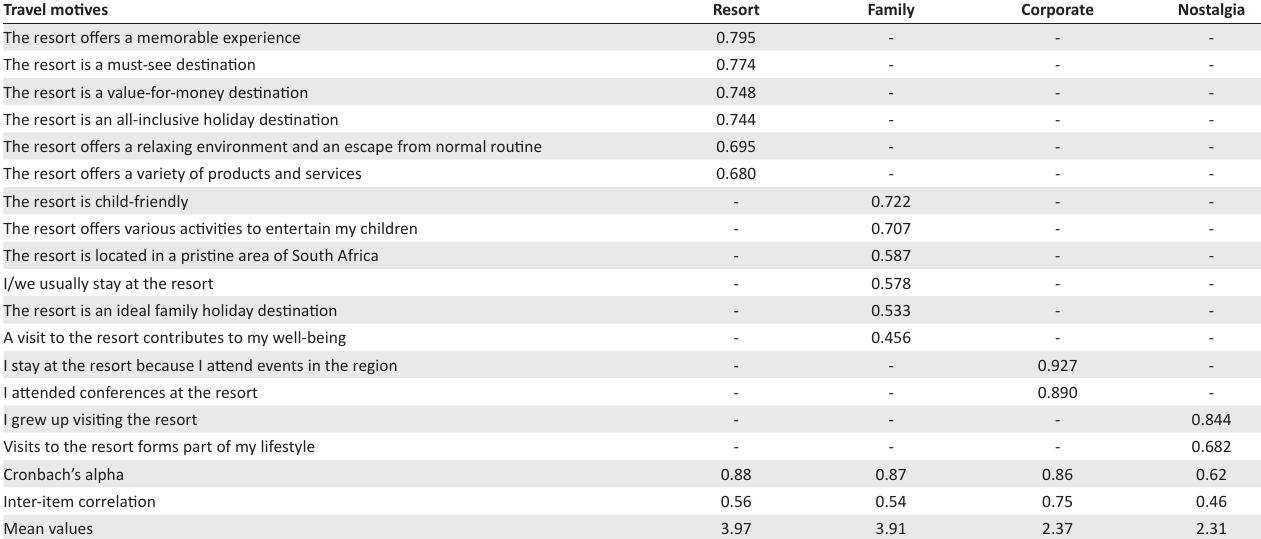
TABLE 4: Results of the factor analysis on resort motives. Travel motives